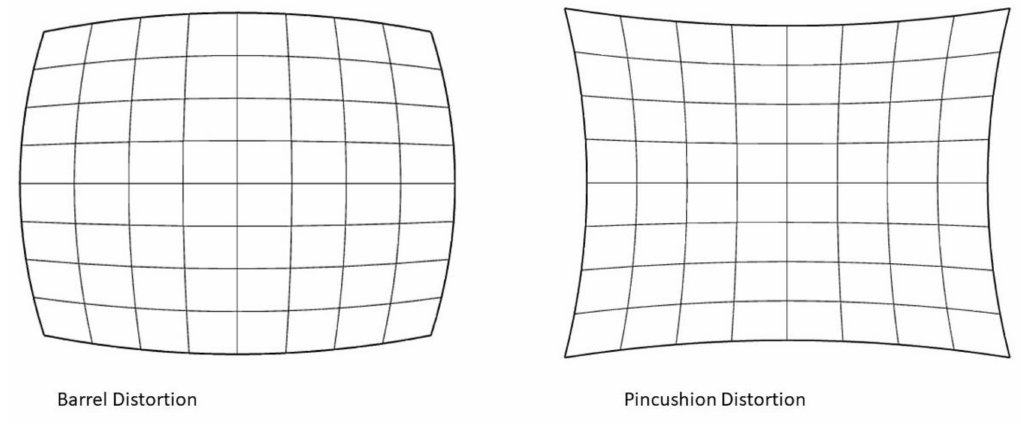
Figure 2. E ff ect of barrel and pincushion distortions (Source: Personal collection, adapted from